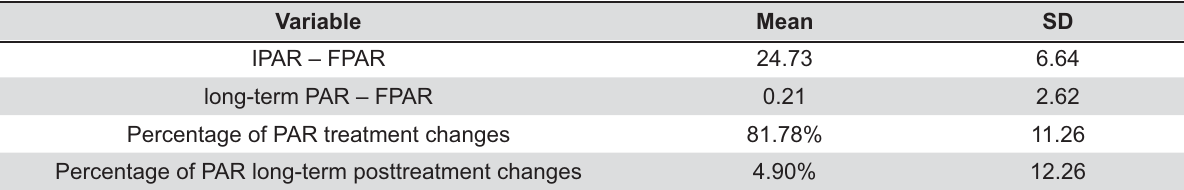
Table 4- Results of the peer assessment rating (PAR) index changes during treatment and during the long-term posttreatment period